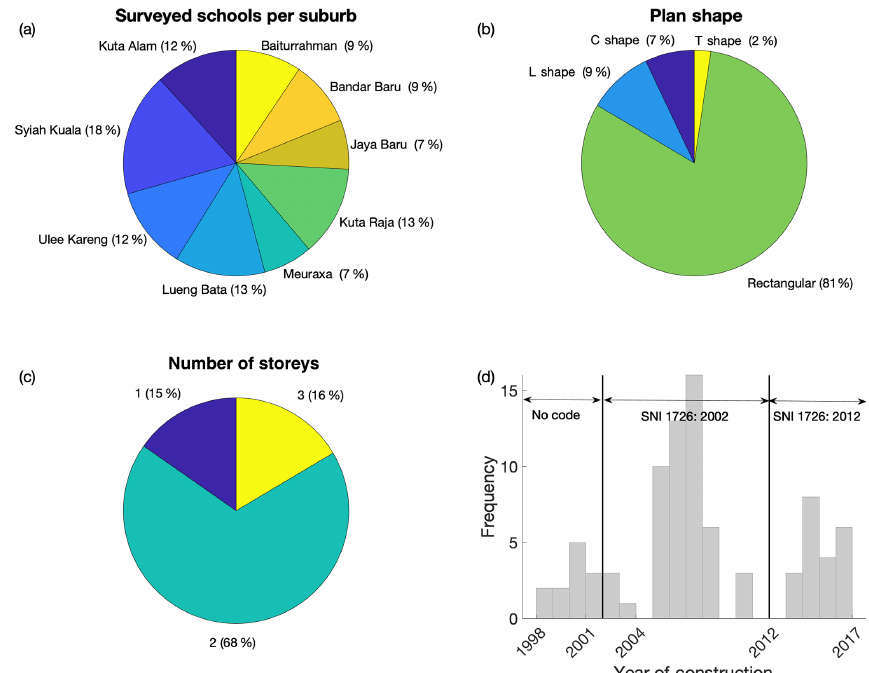
Figure 6. Statistics for the 85 surveyed school buildings. (a) Surveyed schools per suburb; (b) plan shape; (c) number of storeys; (d) year of